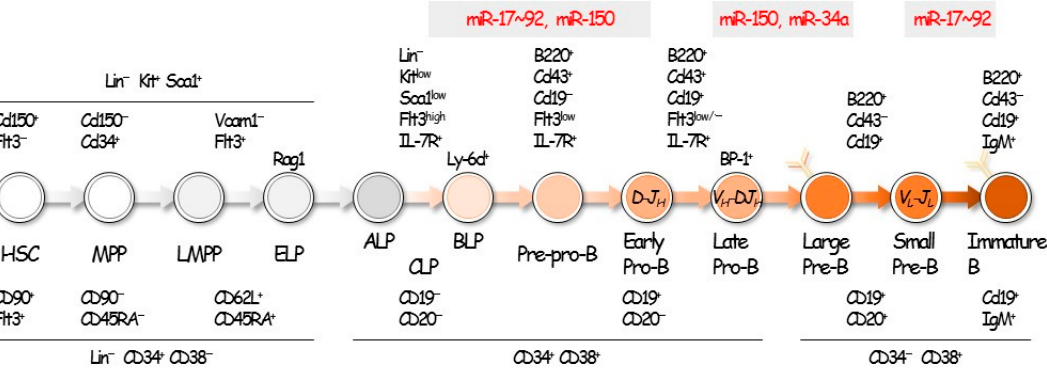
Figure 1. B-cell development and miRNAs. B-cell development is regulated by multiple transcription factors and miRNAs. The expression of miRNAs differs during each stage of B-cell development, and the dysregulation of specific miRNAs impairs B-cell development, causing tumor formation.